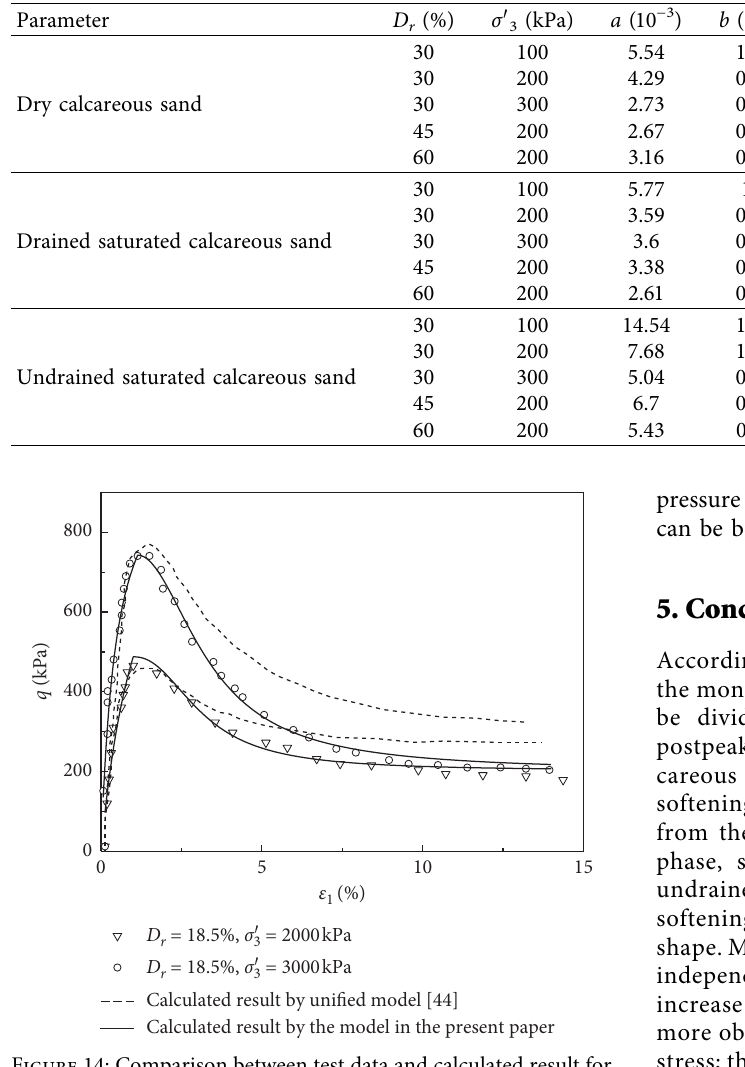
Table 4: Values of model